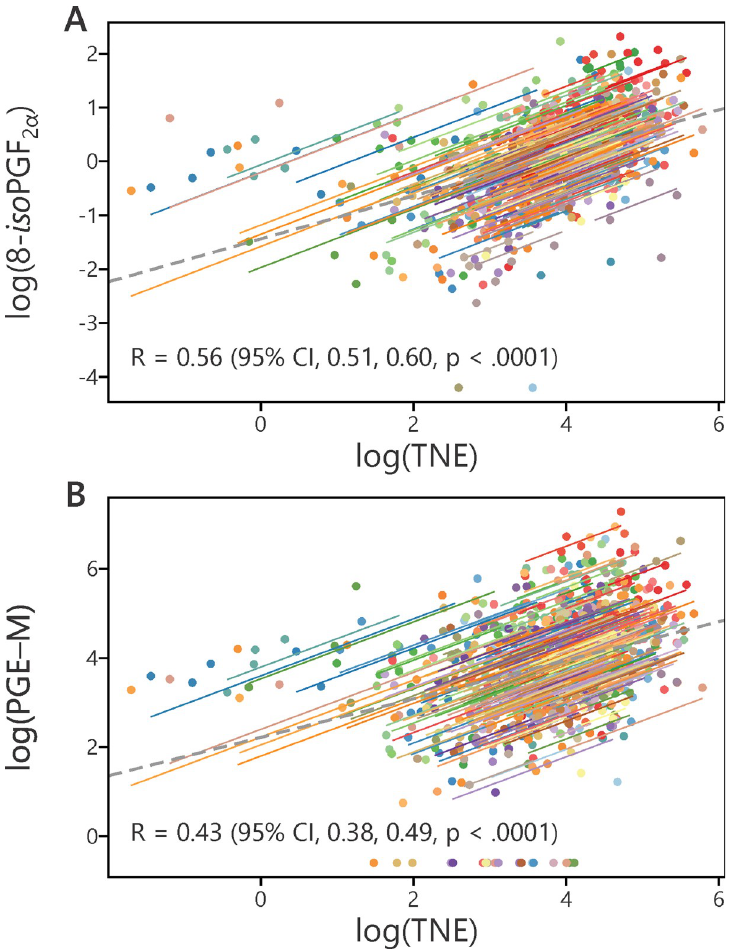
Fig 4. A. Correlation between log 8- iso -PGF 2 α (pmol/mL) and log total nicotine equivalents (TNE) (nmol/mL) R = 0.56 (95% CI, 0.51, 0.60, p < .0001). B. Correlation between log PGE-M (pmol/mL) and log TNE (nmol/mL) R = 0.43 (95% CI, 0.38, 0.49, p <